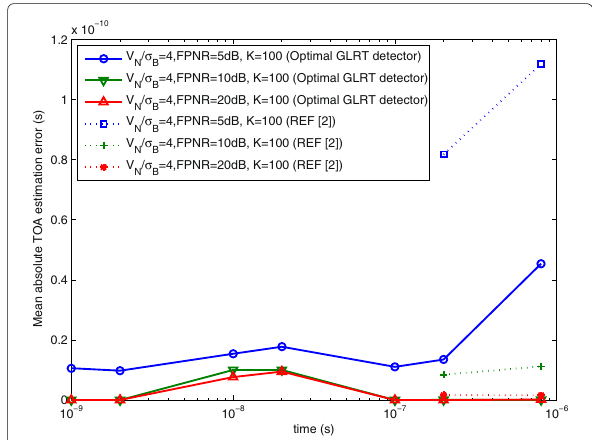
Fig. 7 TOA estimation error for V N /σ B = 4 with FPNR as parameter. This figure compares the TOA estimation error between the proposed GLRT detector and the time-window-based detector of [2] with the true TOA t r ranging from 1 ns to 1 μ s, where the time-window-based detector only works in the t r range from 160 ns to 1 μ s